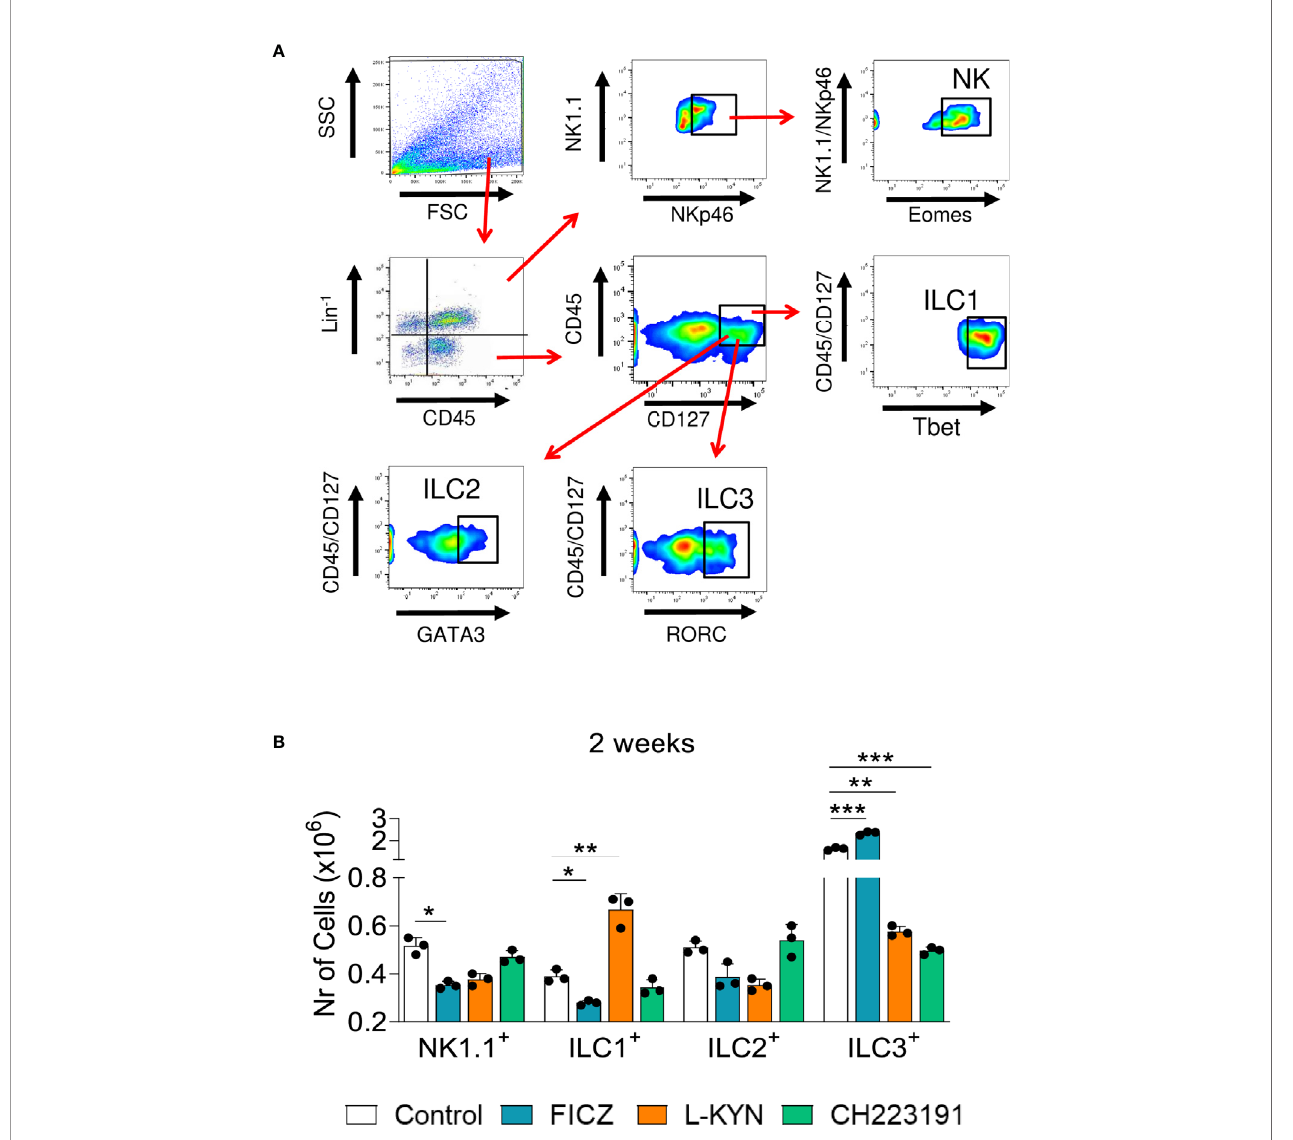
FIGURE 5 | Treatment with AhR ligands alters the expansion and presence of Innate Lymphoid Cells (ILCs) in the lungs of P. brasiliensis infected mice. C57BL/6 mice were infected with 1 x 10 6 P. brasiliensis yeasts and treated with FICZ, L-Kyn, CH223191 as previously described. Control mice were treated with PBS. The animals were sacri fi ced 96 hours and 2 weeks after infection, their lungs removed, macerated, the leukocytes obtained, and analyzed by fl ow cytometry for ILCs phenotypes (NK 1.1, ILC1, ILC2, and ILC3). (A) Gate strategy to de fi ne ILCs subsets. Lung leukocytes were fi rst treated with an anti-mouse lineage cocktail (Biolegend) containing antibodies to CD3, Ly6G/Ly6C, CD11b, CD45R/B220, TER 119/erythroid cells, that react with T cells, B cells, monocytes, macrophages, NK cells, and erythrocytes. NK cells were then classi fi ed as Lin + CD45 + NK1.1 + NKp46 + Eomes + , ILC1 as CD45 + Lin - CD127 + Tbet + , ILC2 as CD45 + Lin - CD127 + Gata3 + , and ILC3 as CD45 + Lin - CD127 + RORC + . The cell surface and intracellular markers were measured by fl ow cytometry and 50.000 cells were counted. (B) Number of NK1.1, ILC1, ILC2, and ILC3 positive cells detected in the lungs of mice at 96 hours and 2 weeks after infection. The experiment was repeated twice and data are expressed as M ± SD. P values < 0.05 were considered signi fi cant (* p < 0.05; ** p < 0.005 and *** p <